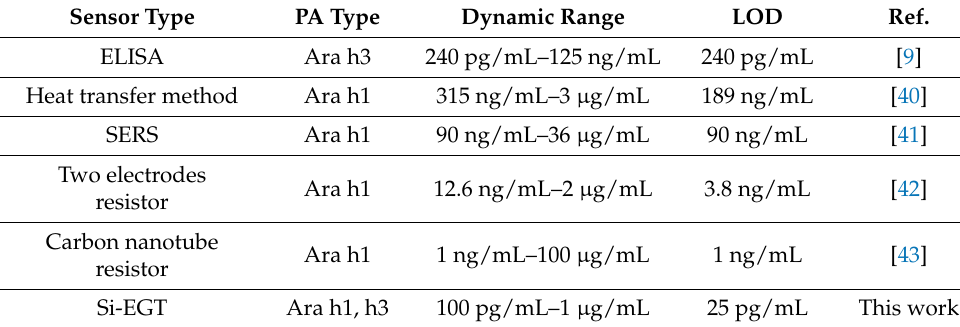
Table 1. LOD comparison between various PA